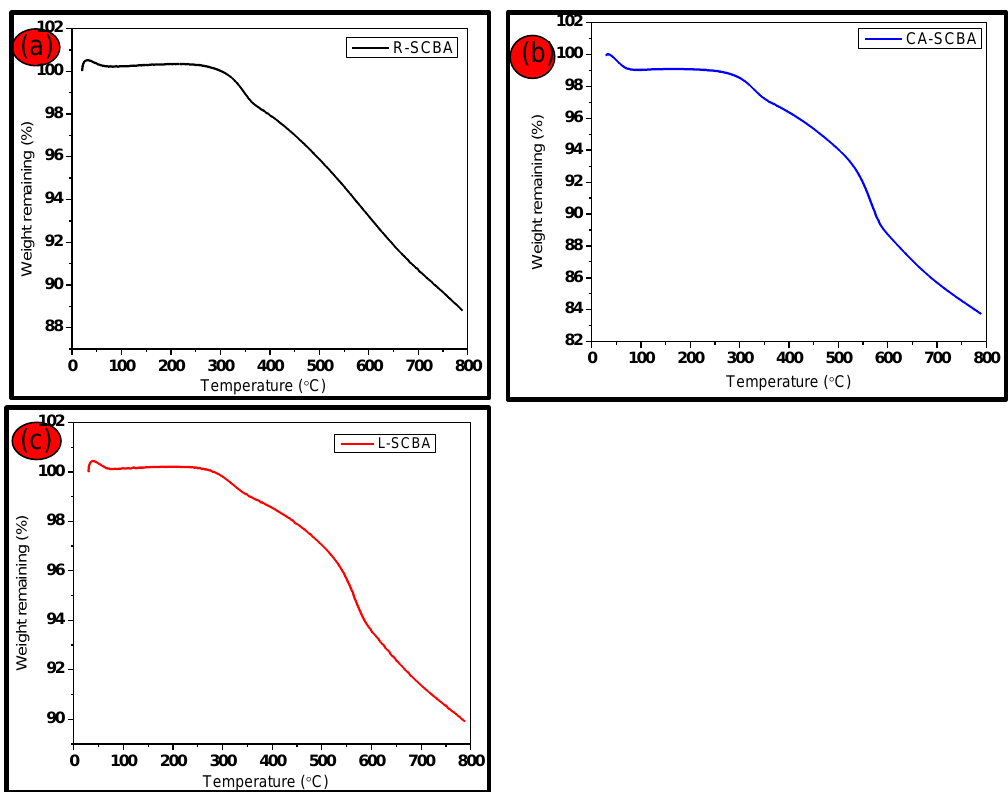
Figure 5. TGA distributions of ( a ) raw SCBA, ( b ) SCBA CA leached ( c ) SCBA L-cys leached respectively.